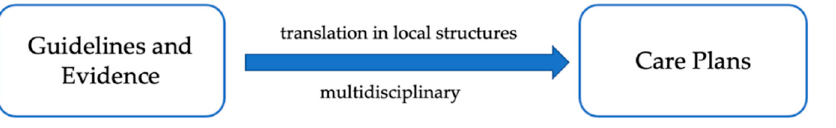
Figure 2. The “classic” clinical pathway on breast cancer.